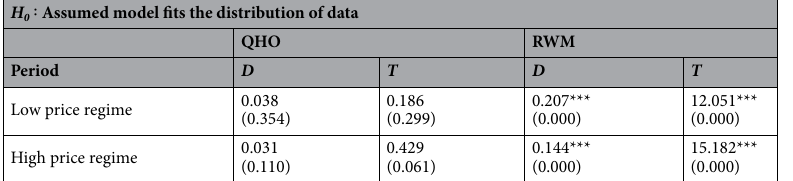
Table 4. The goodness of fit test results on the log return distributions of Bitcoin derived from QHO and RWM. The Kolmogorov–Smirnov test is run by D and Cramer-von Mises test is by T statistics. The cutoff values for T statistics are calculated through Monte-Carlo simulations. In the test, outliers that deviate from Std.Err. are excluded. The numbers in parentheses are p -values of the statistics, the mean by more than 2.58 × where *** represents significance at the 0.1% level.